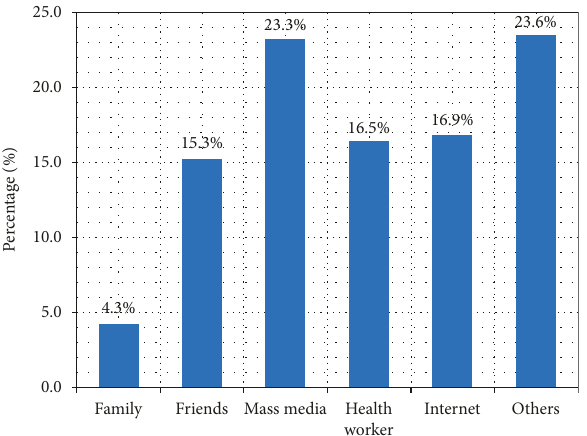
Figure 1: Respondents’ source of information about IVF services.